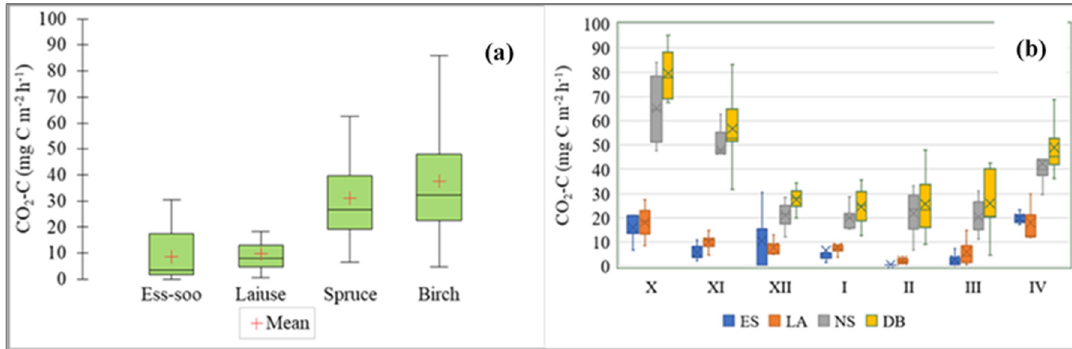
Figure 3. ( a ) Soil CO 2 -C flux in abandoned peat extraction areas (Ess-soo (ES) (n = 25) and Laiuse (LA) (n = 25)) and drained peatland forests (Norway spruce (NS) (n = 41) and Downy birch (DB) (n = 41)). ( b ) Average monthly CO 2 emissions during the winter half-year (months on x-axis are monthly from October (X) to March (IV)). Atmosphere 2020 , 11 , x FOR PEER REVIEW